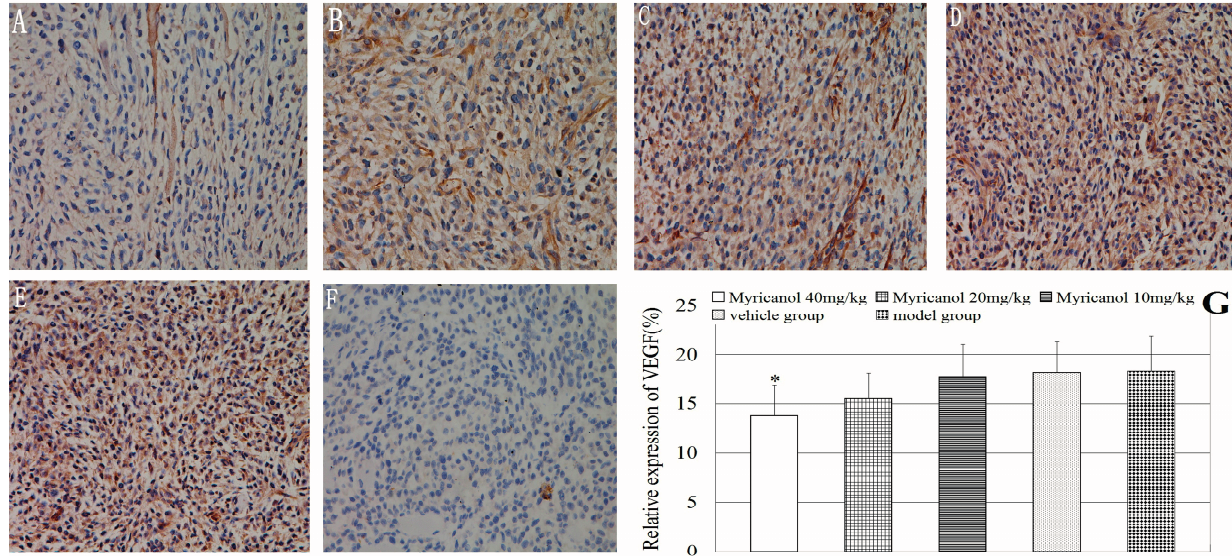
Figure 5. Immunohistochemical detection of VEGF protein in A549 cells (magnification of 400×). The relative expression of VEGF was determined by NIS-Elements D 3.2 image analysis system. ( A ) Myricanol with 40 mg/kg; ( B ) myricanol with 20 mg/kg; ( C ) myricanol with 10 mg/kg; ( D ) vehicle control group; ( E ) tumor model group; and ( F ) isotype control. The yellow and brown particles represent positive VEGF expression; ( G ) Quantification of protein expressions in different groups by IHC. * Compared with the vehicle group, p <